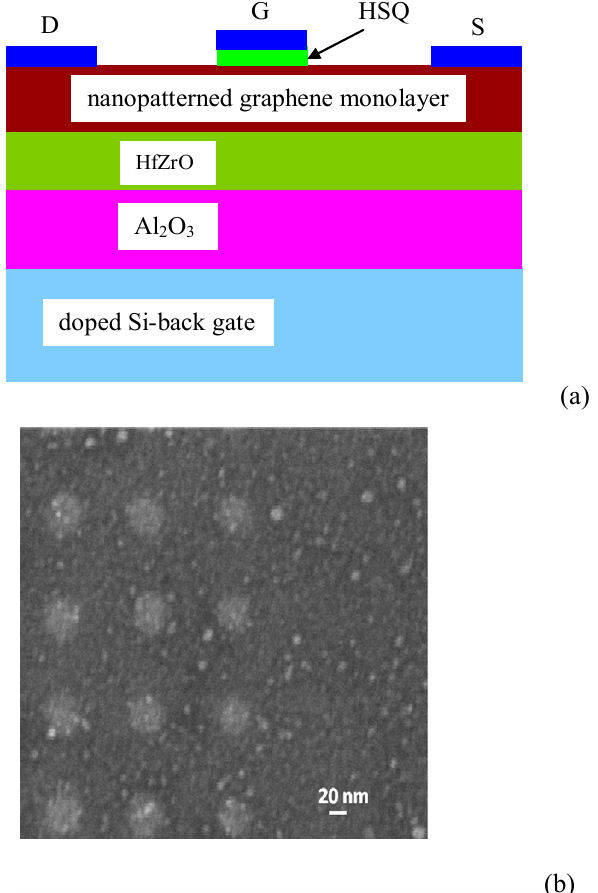
Figure 2. ( a ) Schematic cross section of the ferroelectric nanopatterned FET channel and ( b ) SEM image of the end section of graphene channel.